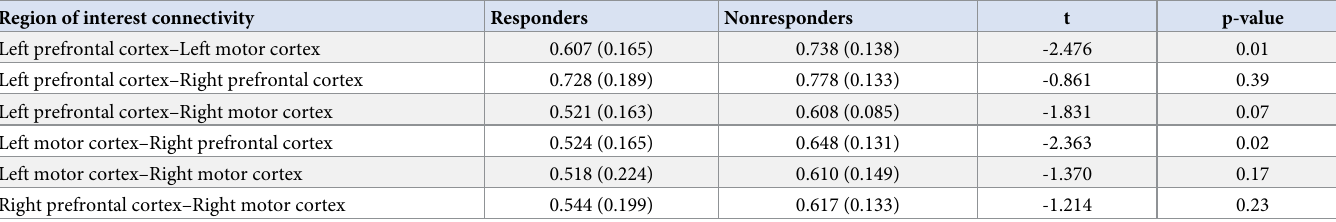
Right prefrontal cortex–Right motor cortex Data are presented as the mean (standard deviation) (n =